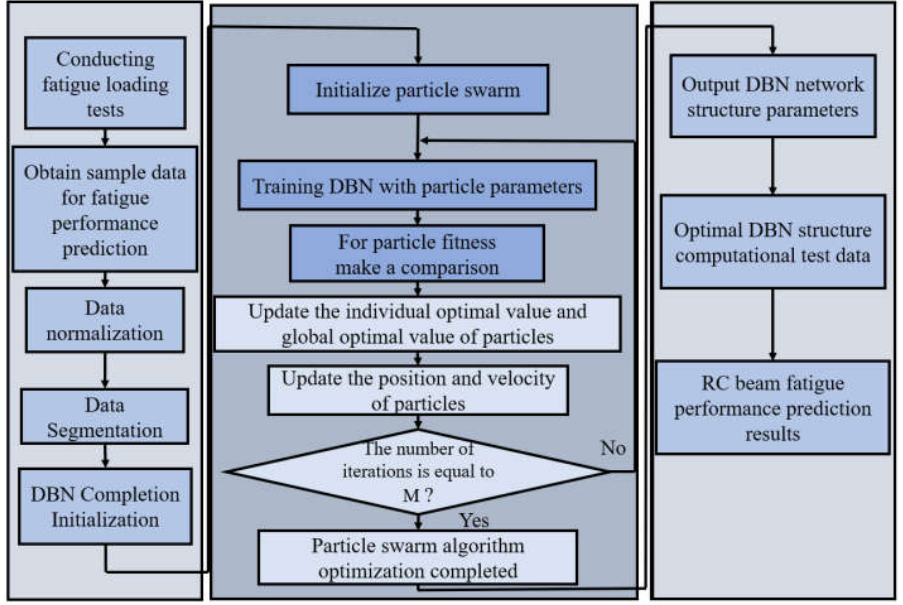
Figure 7. Fatigue performance prediction model of RC beams based on the PSO-DBN.